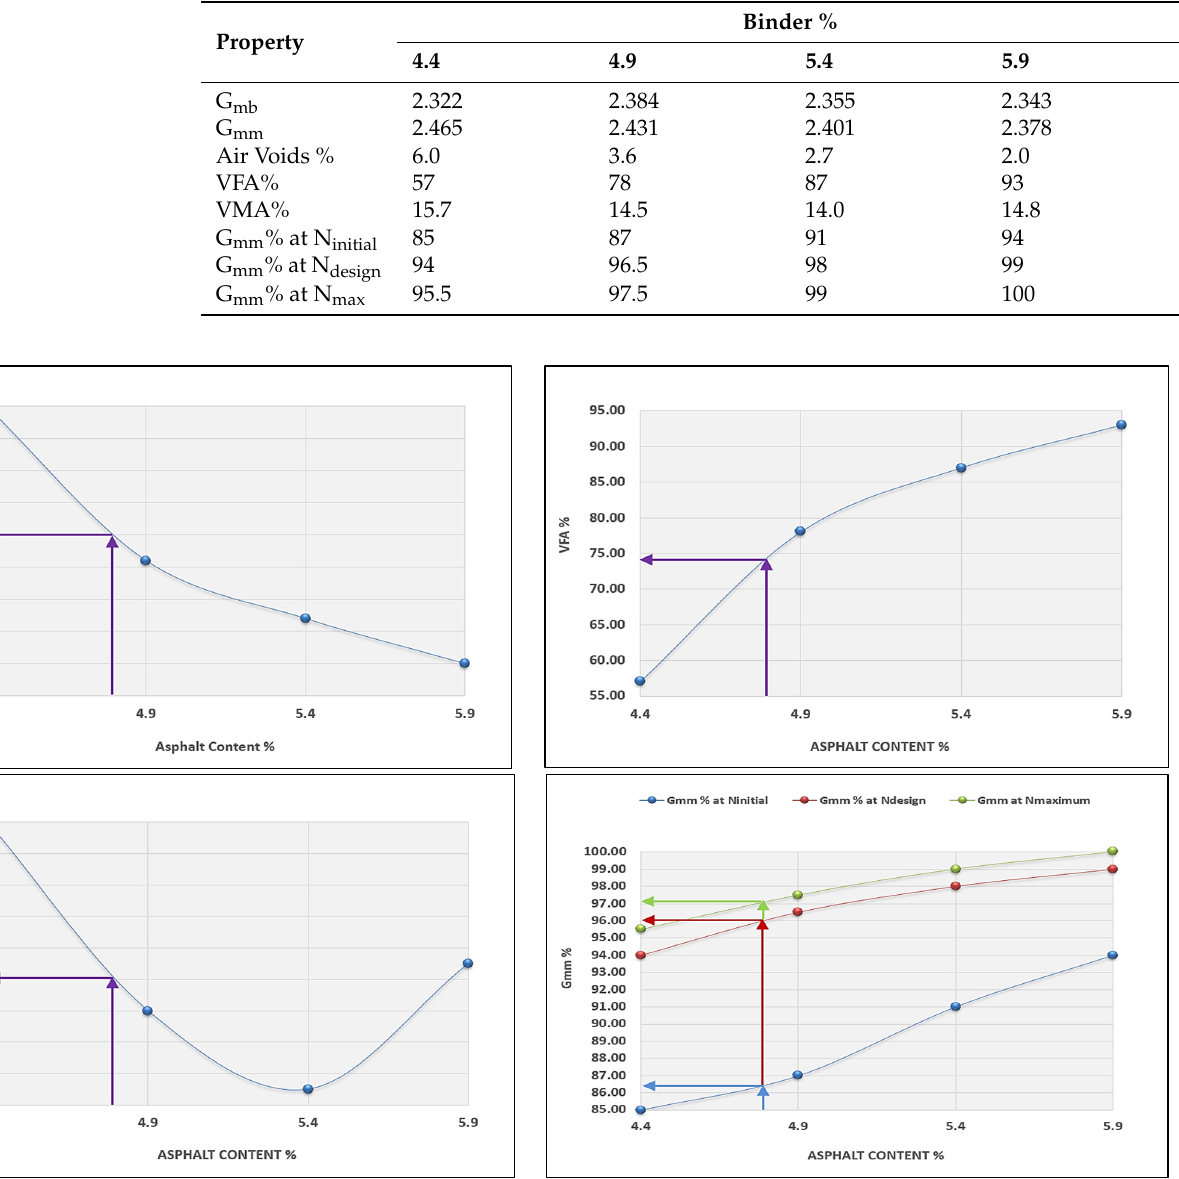
Figure 12. Volumetric properties of trial mixtures.